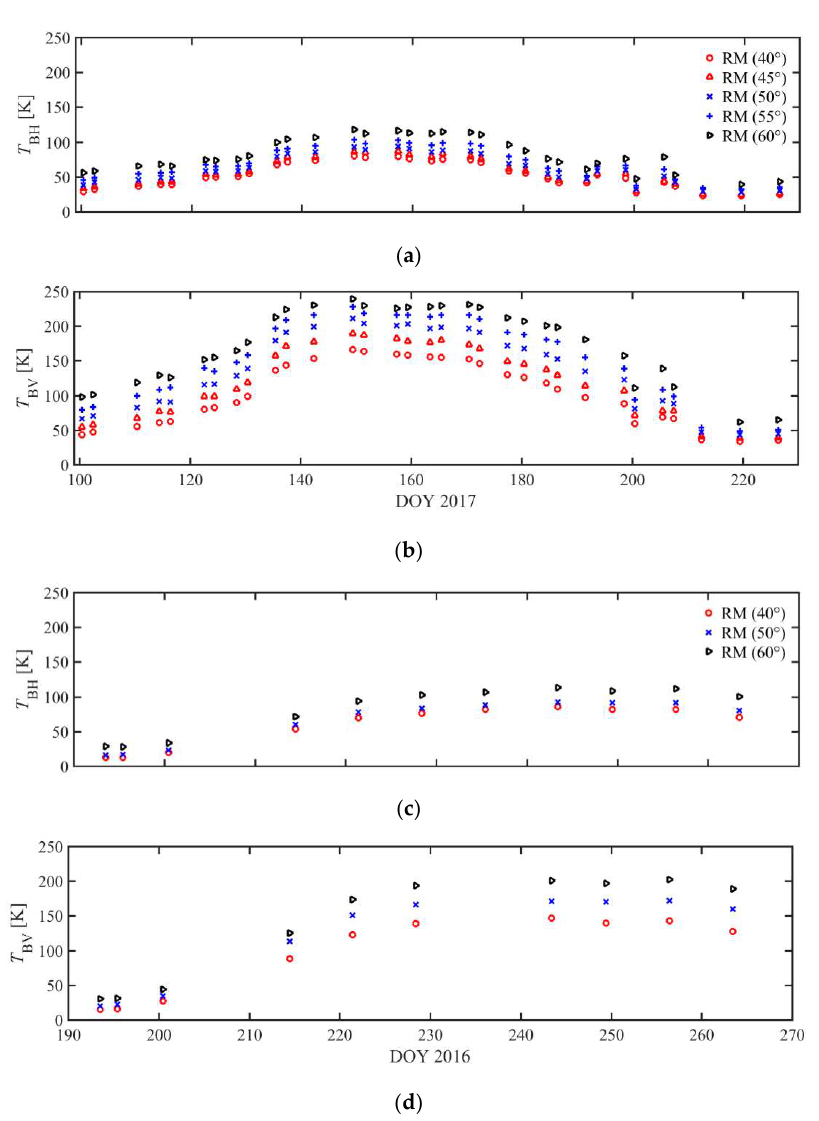
Figure 5. Brightness temperature ( T B ) measured over of the gridded plot covered by wheat vegetation at different incidence angles from 40° to 60° measured in 5° increments for H polarization ( a ) and V polarization ( b ). T B measurements over the gridded plot covered by mustard vegetation, also considering incidence angles from 40° to 60°, but with 10° increments for H polarization ( c ) and V polarization ( d ).